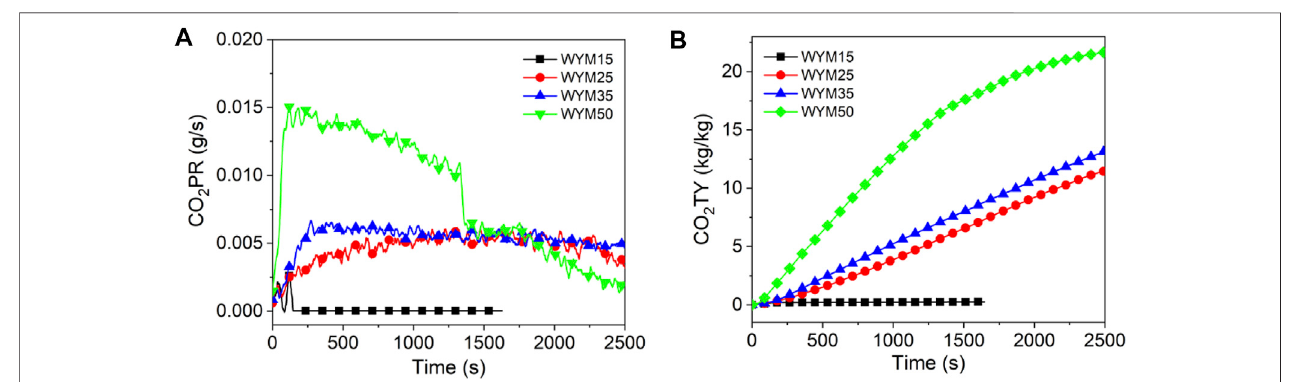
FIGURE 12 | Anthracite curves: (A) PCO 2 PR, and (B) CO 2 TY.